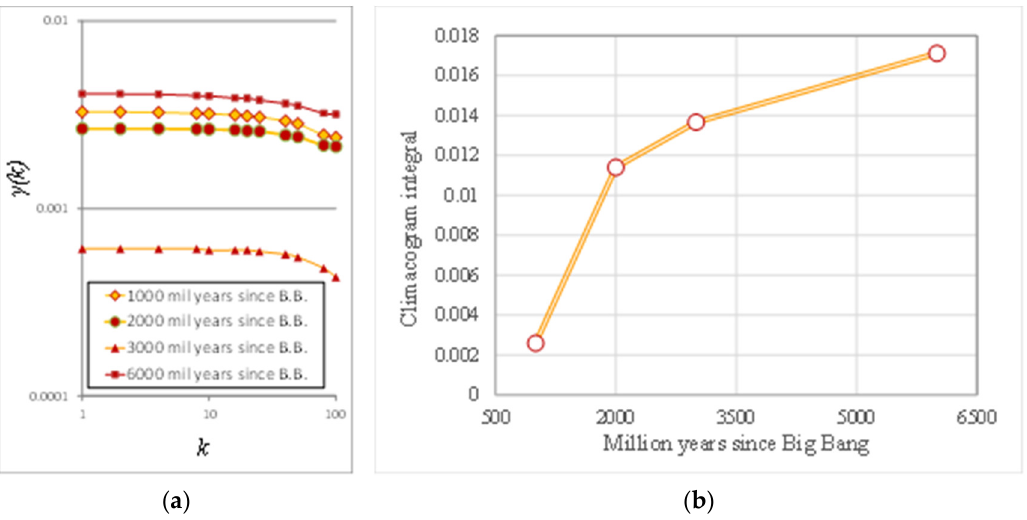
Figure 16. ( a ) Climacograms; ( b ) rate of alteration of clustering through time. Source: [39].